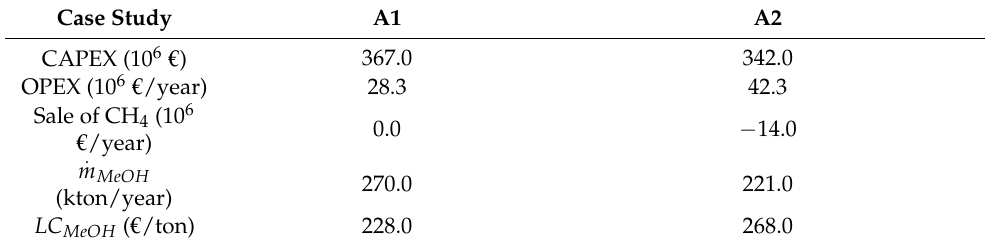
Table 12. Economic data for case studies A1 and A2 (surrounding factor: f e = 1.8). Case